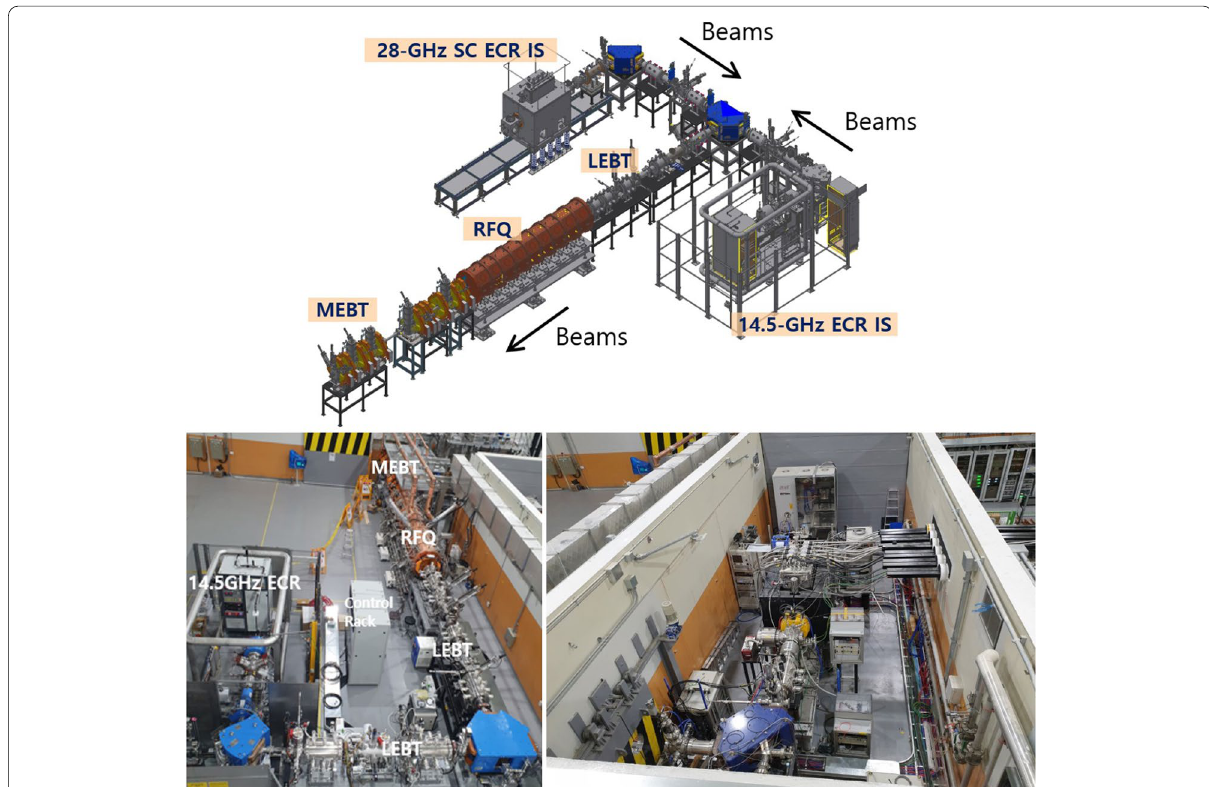
Fig. 3 Schematic (top) and images (bottom) of the injector system. The bottom-right panel shows the 28-GHz superconducting ECR ion source